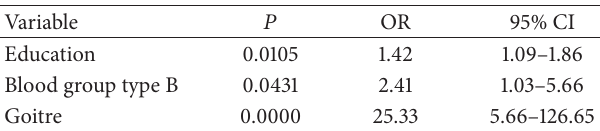
Table 4: Results of multivariate conditional logistic regression